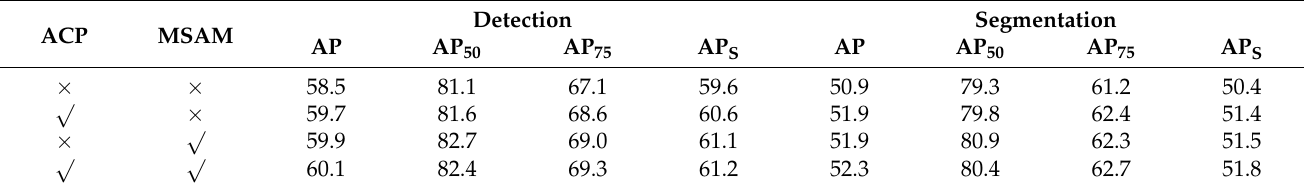
Table 2. The performance of models having MSAM or ACP